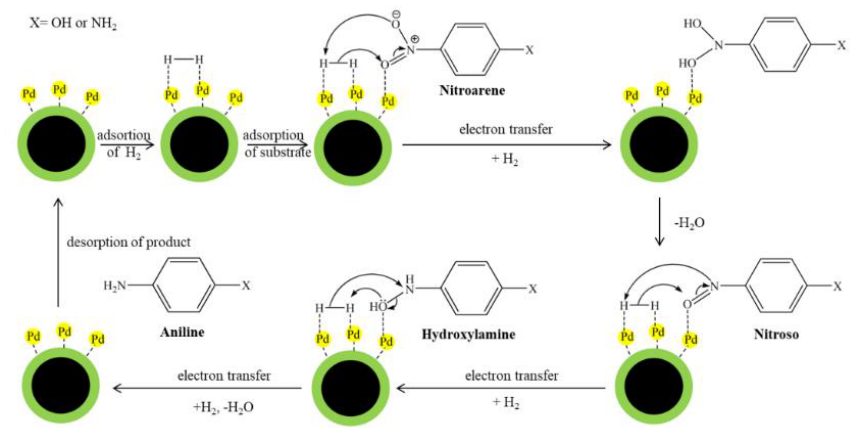
Figure 6. The proposed mechanism for Pd-Chit@MnFe 2 O 4 catalyzed nitroarenes reduction, which involved adsorption of reactants, transfer of electrons, and adsorption of the product occurred at the surface of the catalyst.